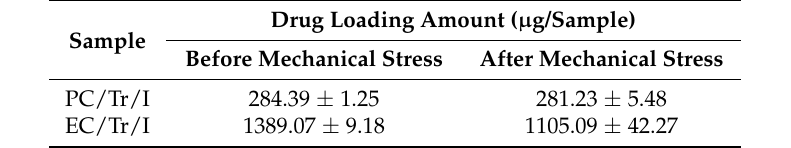
Table 1. Drug loading amounts for the implant samples coated with tranilast-loaded PLGA.